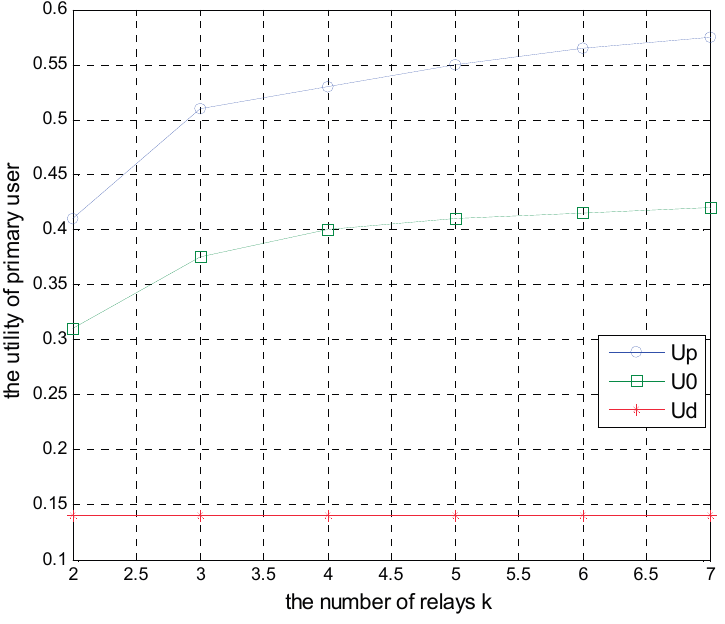
Figure 8. The primary user’s utility function of different schemes with different number of